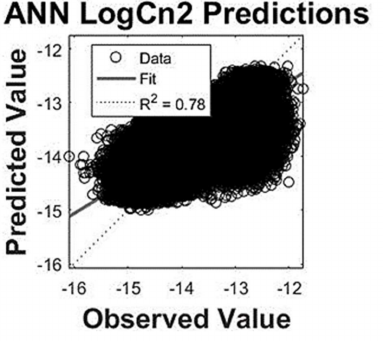
Figure 8. The ANN regression plot for the observed LogC 2 n values against the predicted values for the NPS site